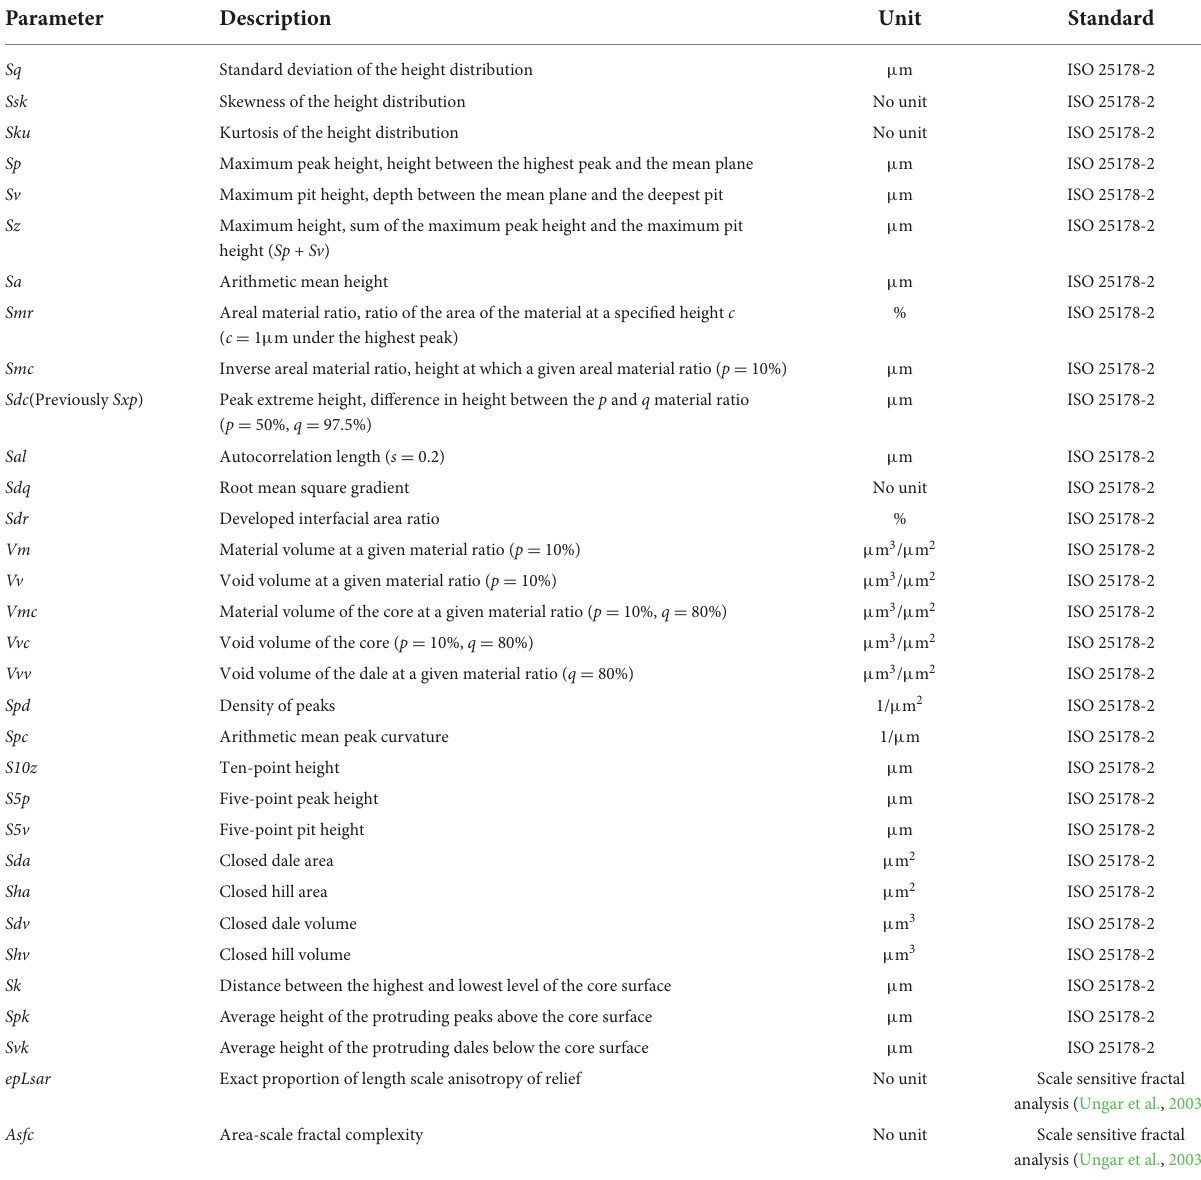
TABLE 3 Names and descriptions of dental microwear texture parameters used in this study.